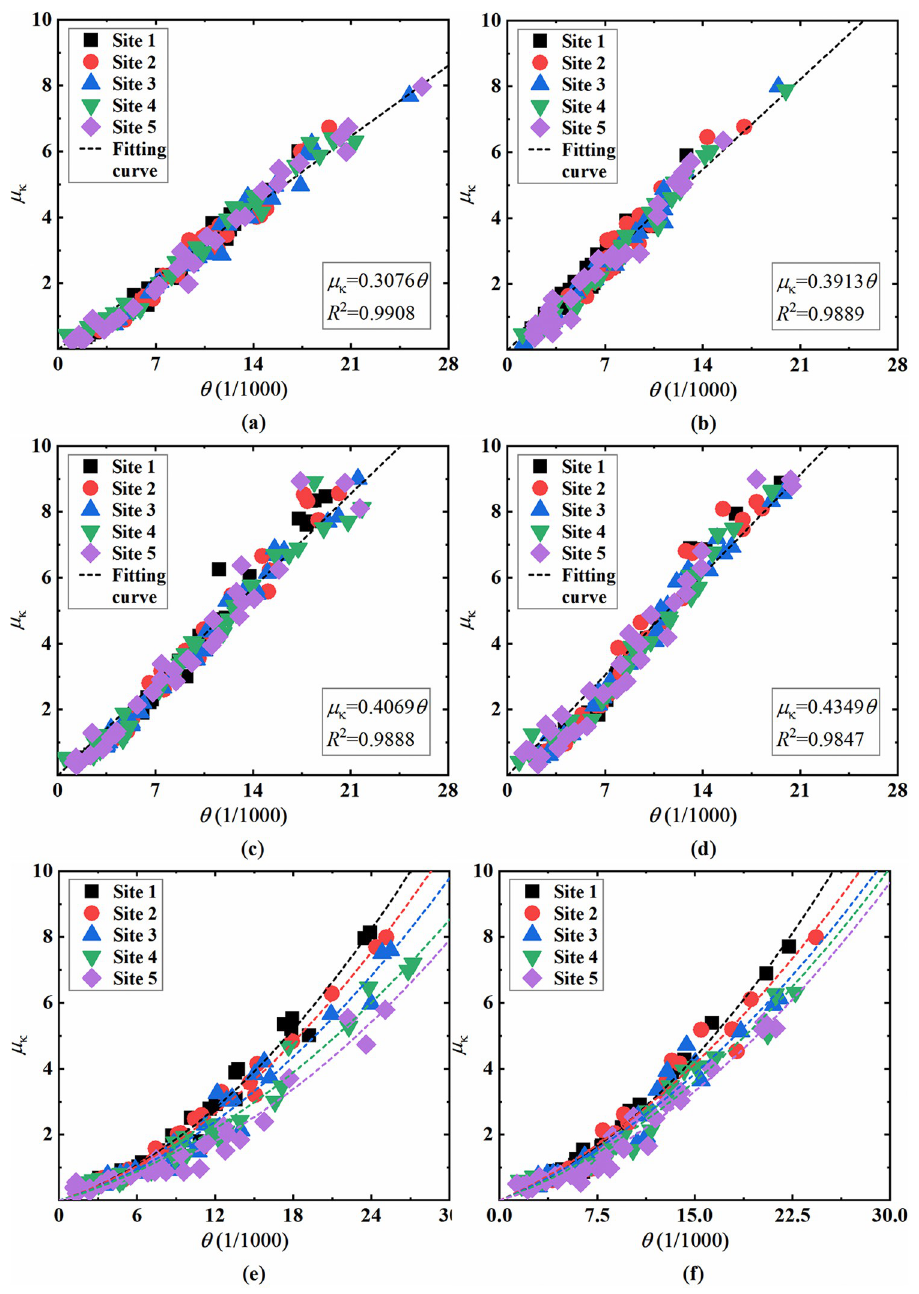
Fig 19. Component bending deformation at different sites. (a) Top column’s top section of the double-storey station, (b) Top column’s top section of the three-storey station, (c) Bottom column’s bottom section of the double- storey station, (d) Bottom column’s bottom section of the three-storey station, (e) Sidewall’s bottom section of the double-storey station, (f) Sidewall’s bottom section of the three-storey station. column’s top section and the bottom column’s bottom section are given in Fig 19(A) to 19(D), whose corresponding determination coefficients ( R 2 ) of the fitting functions are all above 0.98, showing a high correlation. The results of different sites demonstrate no significant difference since the columns have no direct contact with the surrounding soil, and their deformation is